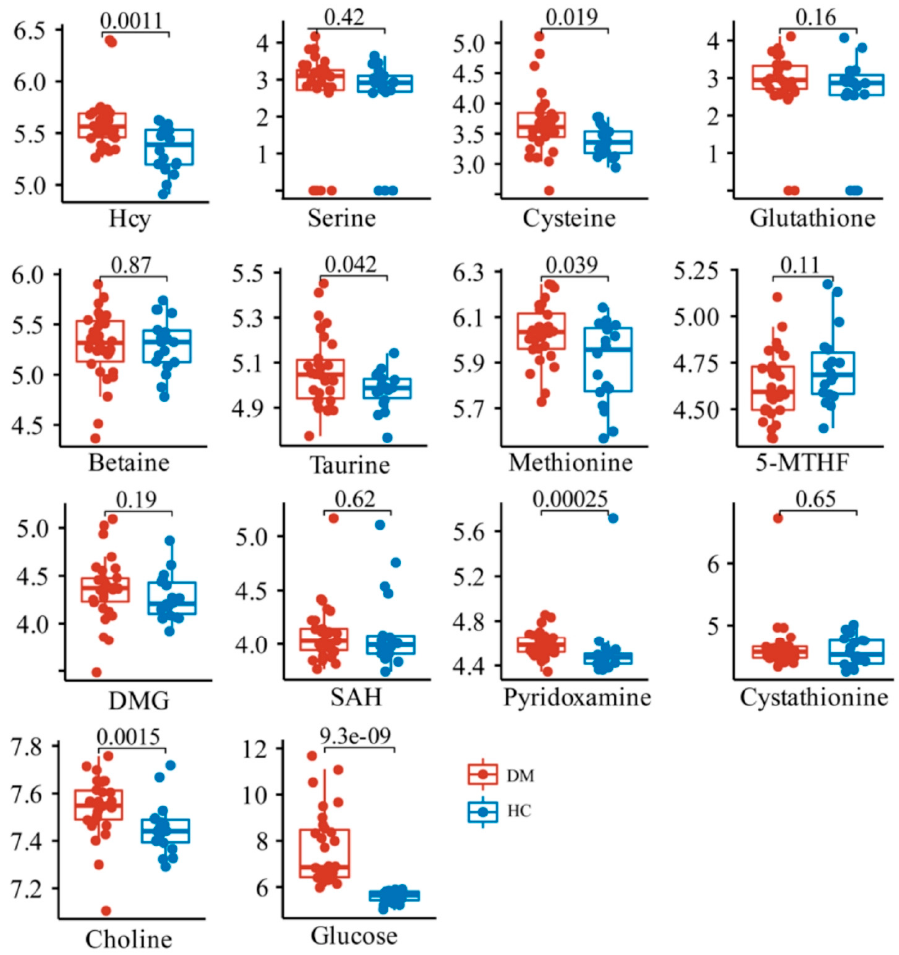
Figure 3. Comparison of relative contents of 13 metabolites in HC and DM groups.